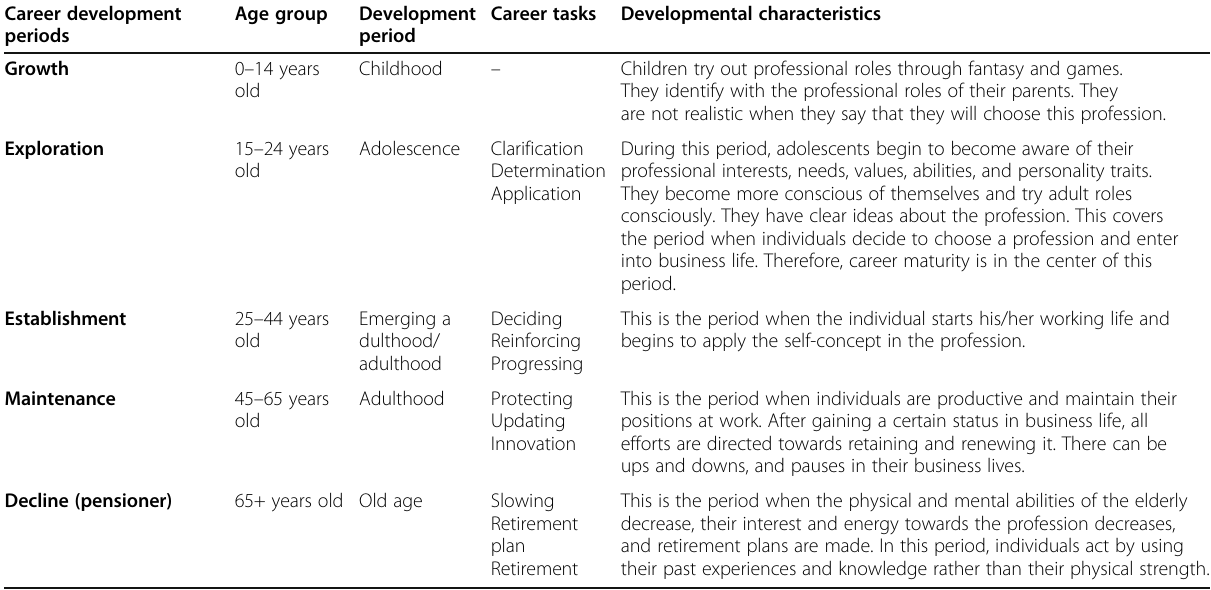
Table 1 Career development periods and career development tasks (Super, 1980) Career development